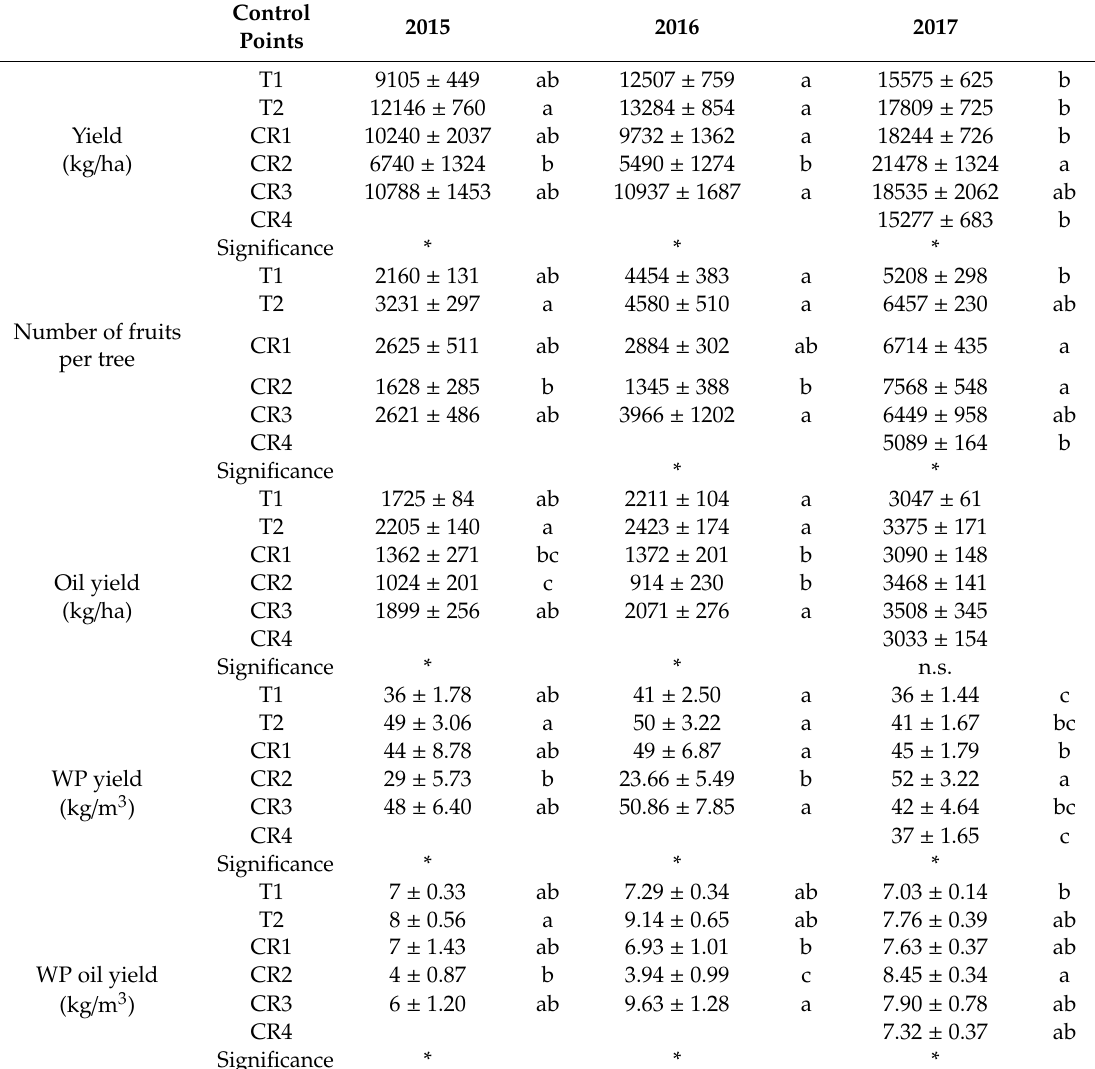
Table 6. Mean values ± standard error of yield, number of fruits per tree, oil yield and water-use e ffi ciency during the three study